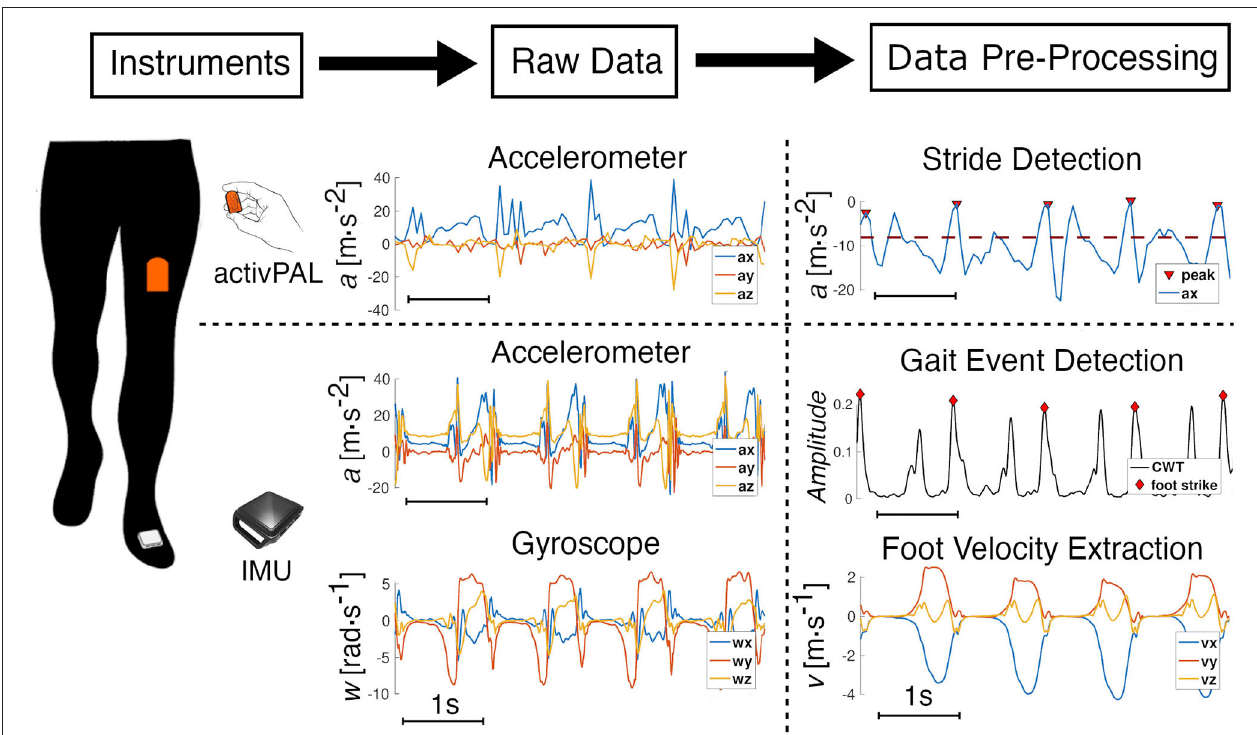
FIGURE 1 | Data processing. Data extraction and pre-processing from the synchronized activPAL (AP) and the IMU. A representative window of four strides illustrates the pre-processing of the raw data from both sensors. The AP is worn on the thigh, and the accessible raw data is from the embedded three-axis accelerometer. The x-axis signal, which is from the sensor-axis that is aligned with the thigh and is positive in the inferior direction, is smoothed and a peak detection (threshold in red-dotted line) method enables the detection of each stride. For the IMU, raw data from the embedded three-axis accelerometer and gyroscope are processed using a continuous wavelet transform to detect gait events; foot velocity and position are then calculated using a ZUPT